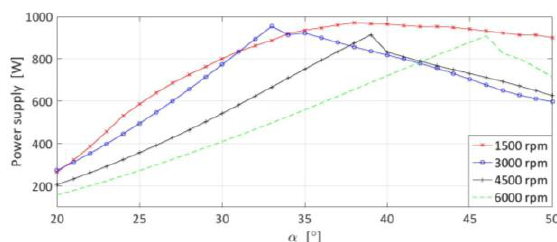
Fig. 4. Power supply vs. phase supply ranges α s at different rotational speeds in the serial configuration (S).